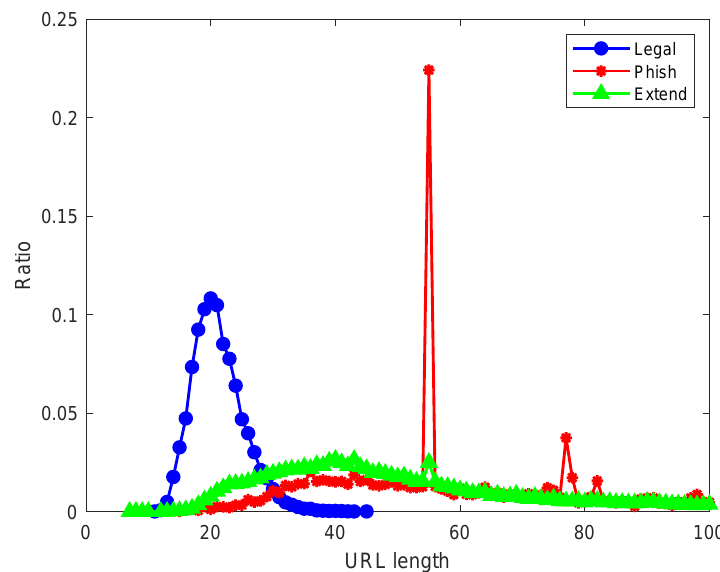
Figure 10. Ratios of websites with different URL